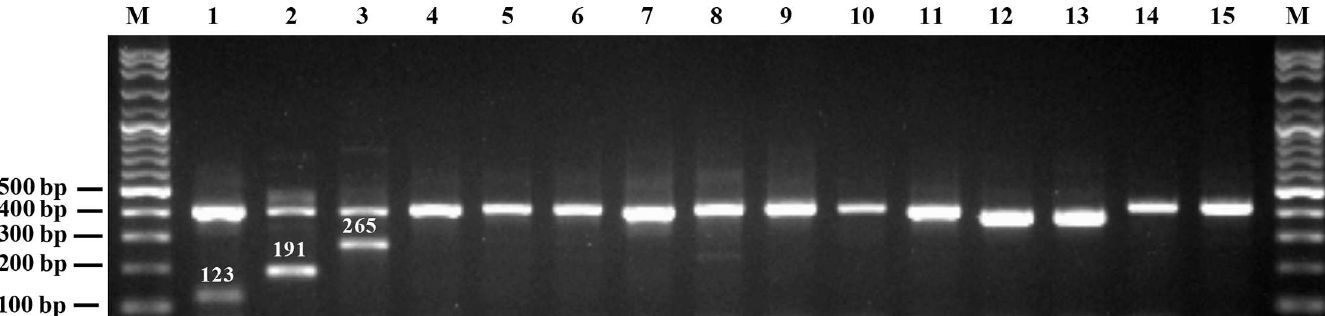
Fig 2. Image of PCR products generated with a set of species-specific PCR primers in the ITS2 region of “Krai-Krue” herbs as detected by 1.7% agarose gel electrophoresis. Lane 1: Aristolochia pothieri ; lane 2: A . pierrei ; lane 3: A . tagala ; lane 4: A . ringens ; lane 5: A . kerrii ; lane 6: A . littoralis ; lane 7: A . grandiflora ; lane 8: A . gigantea ; lane 9: A . tentaculata ; lane 10: A . anguicida ; lane 11: Gymnopetalum integrifolium ; lane 12: Raphistemma pulchellum ; lane 13: Jasminum sp .; lane 14: J . sambac ; lane 15: J . adenophyllum and M: VC 100-bp plus DNA ladder. https://doi.org/10.1371/journal.pone.0202625.g002 PLOS ONE | https://doi.org/10.1371/journal.pone.0202625 August 20,